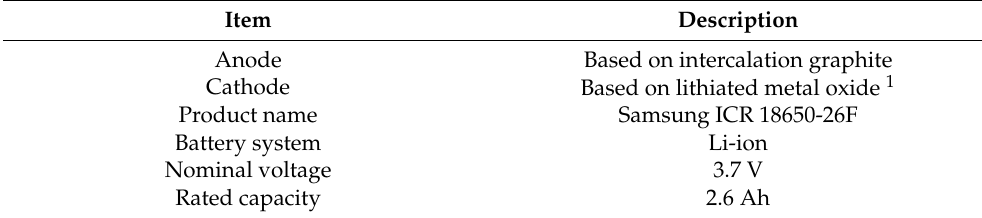
Table 1. Specifications of the Li-ion